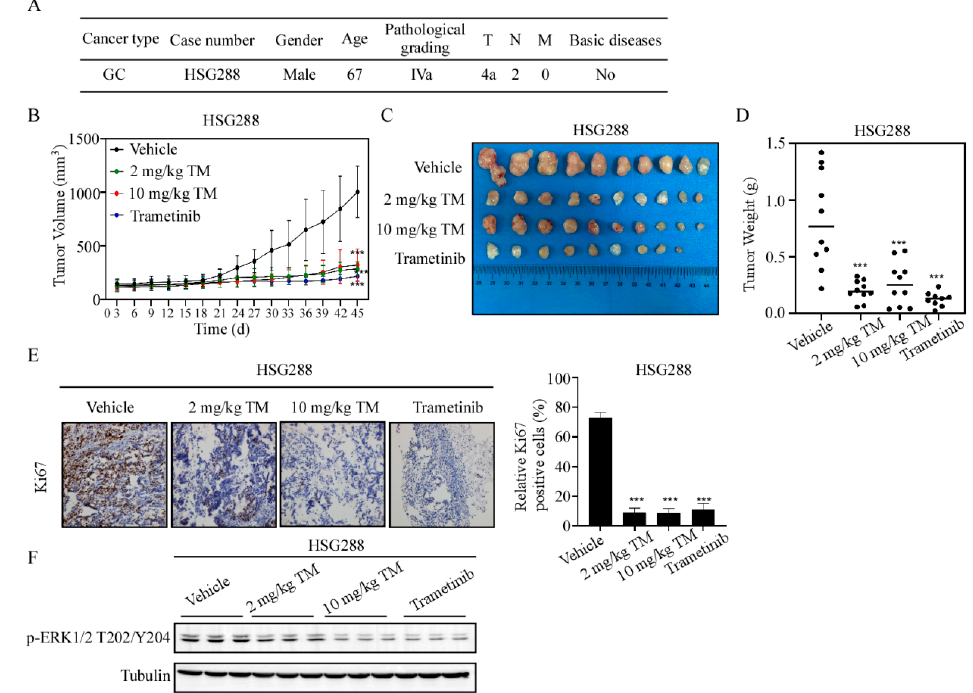
Figure 6. Tegaserod maleate has the same inhibitory effect compared with MEK1/2 inhibitor trametinib. ( A ) Patient information for samples used in the GC PDX models. ( B ) The change in average tumor volume in different groups of HSG288 cases after tegaserod maleate and trametinib treatment. ( C ) Tumor images of different groups after sacrifice. HSG288 (n = 10). ( D ) Tumor weight analysis in different groups of HSG288 cases after tegaserod maleate and trametinib treatment. ( E ) Left panel: Representative IHC images of HSG288 tumor tissue slices (100 magnifications), tumor tissues were stained with Ki-67 antibody; Right panel: Statistical analysis of IHC positive staining of Ki-67 in HSG288 cases. ( F ) The protein levels of p-ERK1/2T202/Y204 in tumor tissues were detected using Western blotting. The asterisks (***) indicate a significant ( p <